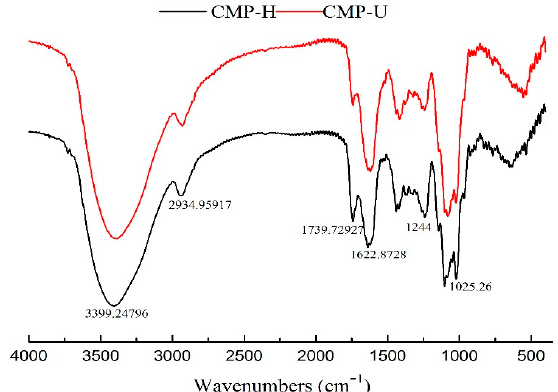
Figure 5. Fourier transform infrared (FT-IR) spectra of CMP-H and CMP-U. CMP-H: C. morifolium polysaccharides obtained by hot reflux extraction; CMP-U: C. morifolium polysaccharides obtained by ultrasonic assisted extraction.